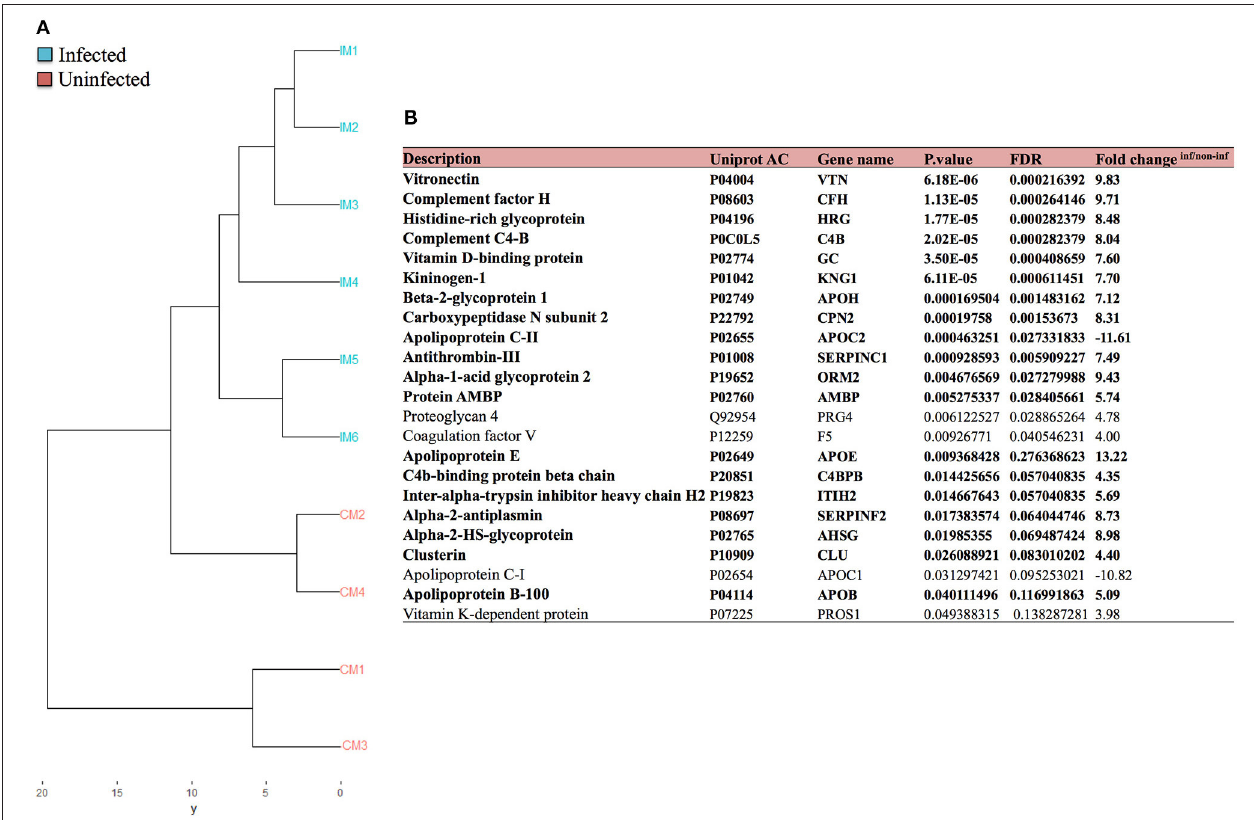
FIGURE 4 | Comparison of human liver proteins from P. vivax infected FRG KO huHep mice with plasma proteins from patients in natural infections. (A) Dendogram depicting the results of a statistical comparison (supervised and lineal methods) between the human proteins identified by LC-MS/MS-based proteomics in enriched exosomes derived from plasma of P. vivax infected and uninfected FRG huHep mice from EI1. IM-1 to IM-6 (Infected mice), CM-1 to CM-4 (uninfected mice). Supporting data are shown in Data Sheet 3 . (B) Twenty-three human proteins found to be significantly over-represented in infected FRG KO huHep mice ( P -value < 0.05, FDR adjusted) were compared with the proteome of total plasma proteins from P. vivax patients ( Ray et al., 2016). Nineteen proteins (in bold) were detected in both